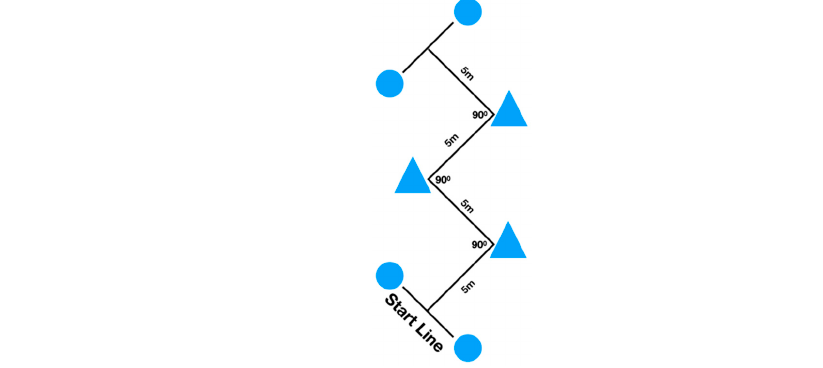
Figure 2. Schematic presentation of the 135° change of direction test. Circles represent the positions of the photocells. 2.3.4. Change of Direction Deficits